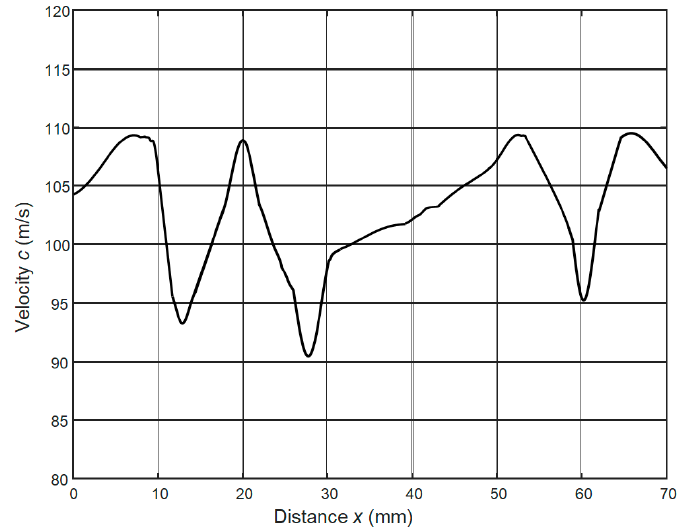
Figure 23. Spatial distribution of the phase velocity reconstructed from the contact B-scan.